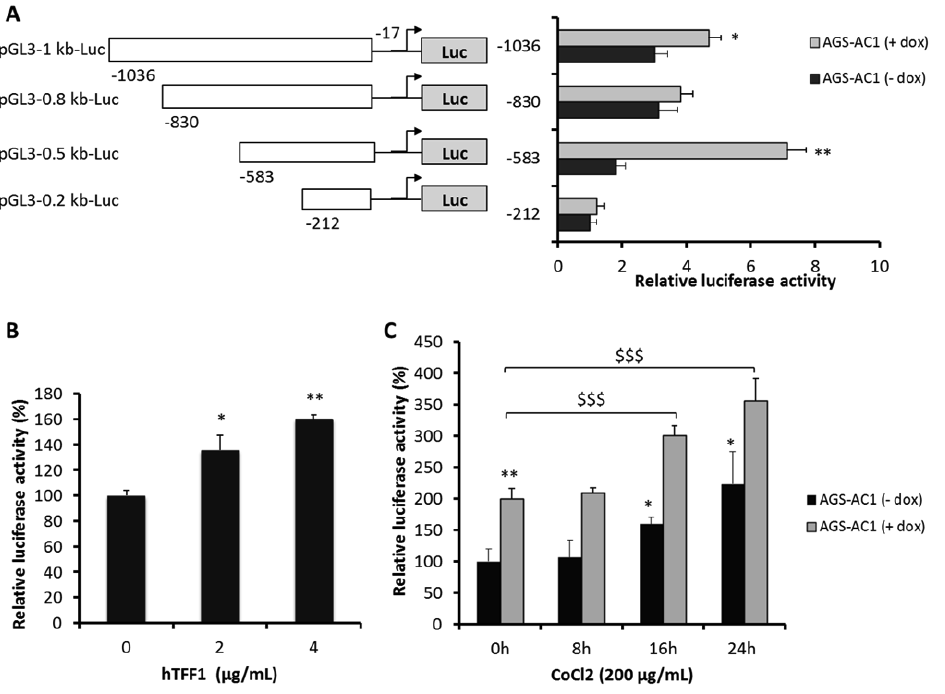
Figure 6. Regulation of the TFF1 promoter by TFF1 itself and hypoxia. ( A ) Schematic